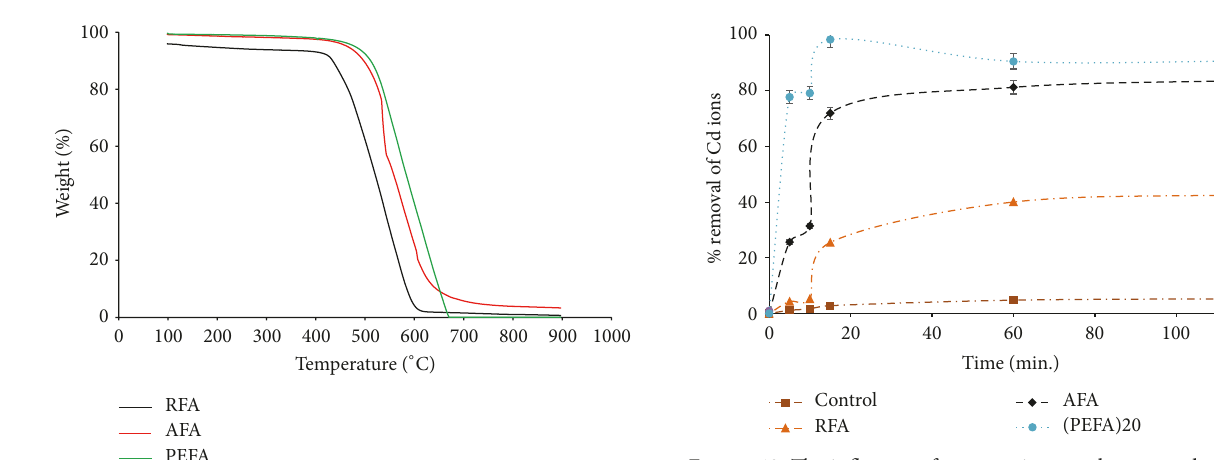
Figure 10: The influence of contact time on the removal efficiency of Cd (II) ions on FA based adsorbents (RFA, AFA, and PEFA) as a function of pH value of 9, 2mg/L metal ion concentration, 4g/L adsorbent dosage, mixing rate of 150rpm, 50 mL volume of aqueous solution, and 298 K